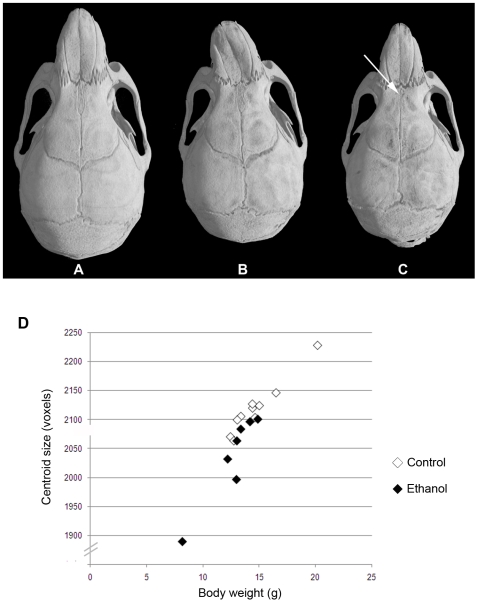
Variable midfacial dysmorphism and microcephaly in a/a offspring of mothers that consumed ethanol during gestation.The top panel shows 3D reconstructions of skull microCT data from 28–30 day old mice. (A) Control female. (B) Ethanol-exposed male showing marked leftward deviation of the midface. (C) Ethanol-exposed female showing an almost absent interfrontal bone that is normally characteristic of untreated C57BL6/J mice. (D) Graph of centroid size (used as an estimate of overall cranial size) against body weight for control (n = 10) and ethanol exposed (n = 7) mice at 28–30 days old. Centroid size was determined by summing the distances from each landmark to the centroid for each individual. Centroid size is highly correlated with body weight in both treatment groups, but those in the ethanol group are on average smaller than those in the controls (ANOVA, p<0.05).